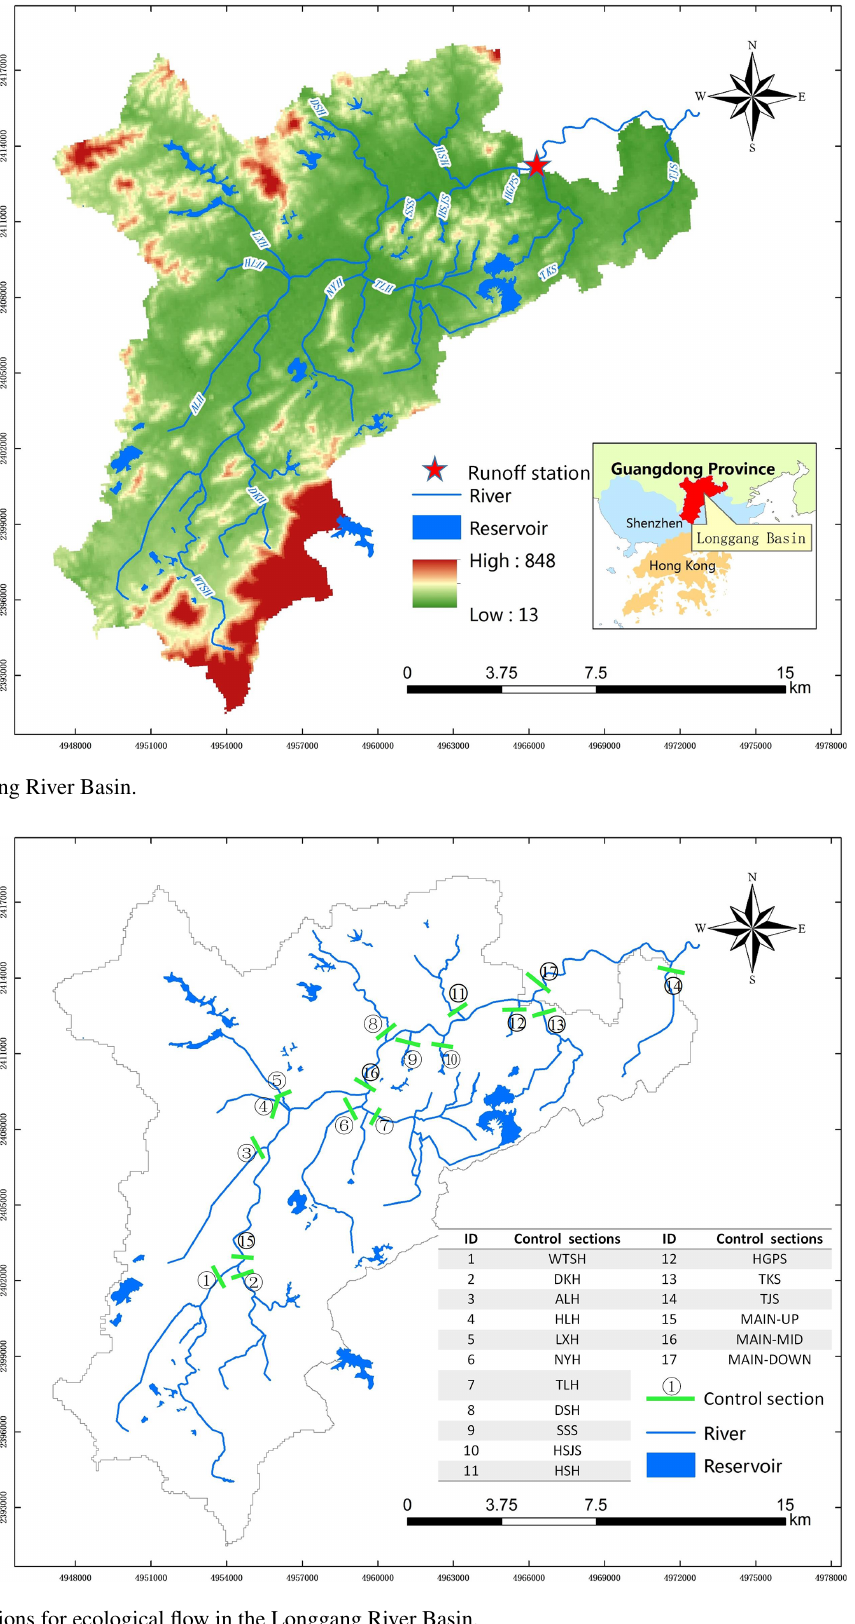
Figure 3. Control sections for ecological flow in the Longgang River